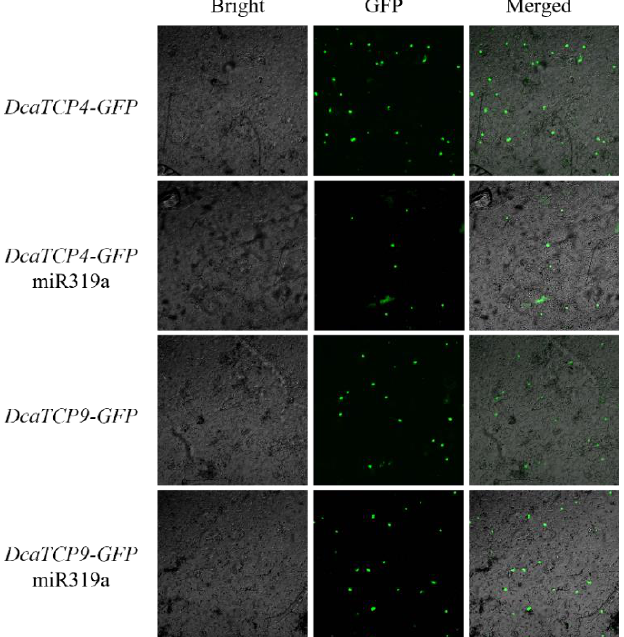
Figure 4. Complementarity analysis of miR319a and target genes. GFP (Green Fluorescent Protein) is a versatile biological marker. Bar = 50 µ